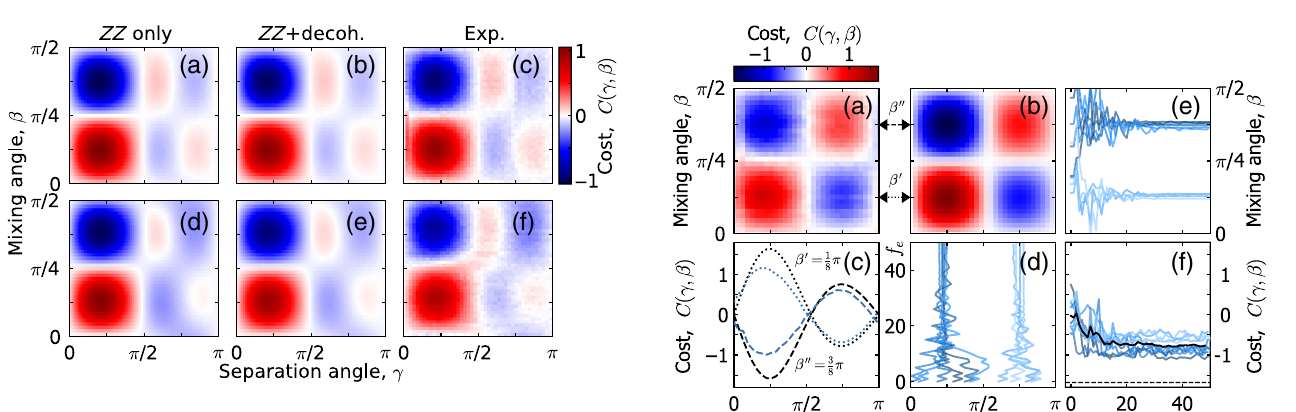
FIG. 12. Simulated and experimental cost-function landscapes of the three-qubit problem instance for p = 1. The direct imple- mentation is displayed in (a)–(c). The decomposed version is shown in (d)–(f). The master-equation simulations are performed including errors from residual ZZ coupling only (a),(d), and with both residual ZZ coupling and decoherence (b),(e). The experimental data is shown in (c),(f).